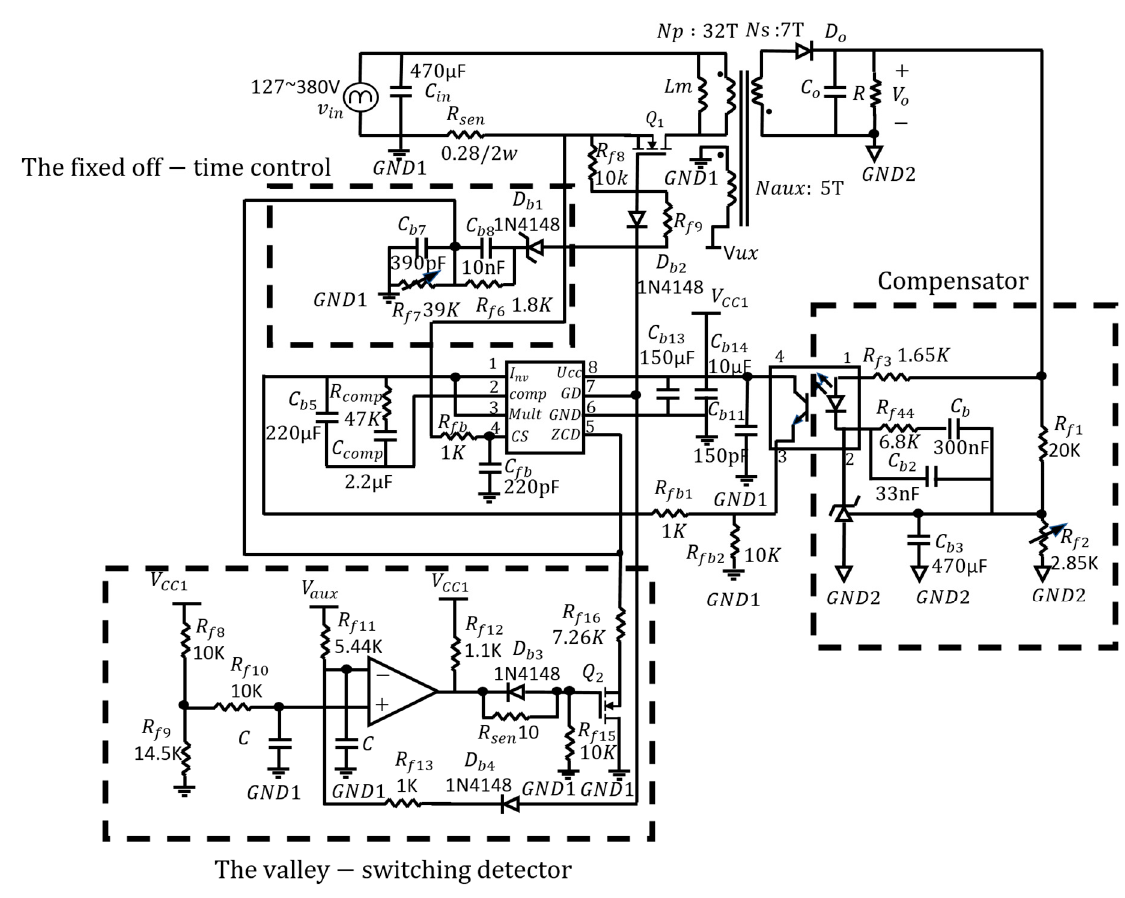
Figure 5. Block diagram of the voltage closed-loop control of the DMBFC.